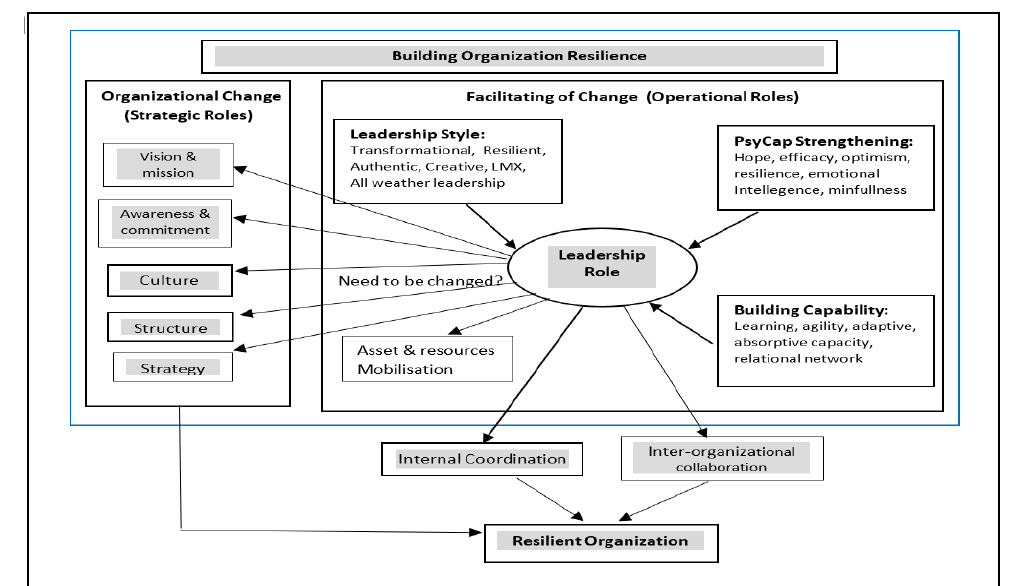
Figure 1. Framework of Leadership in Building Organizational